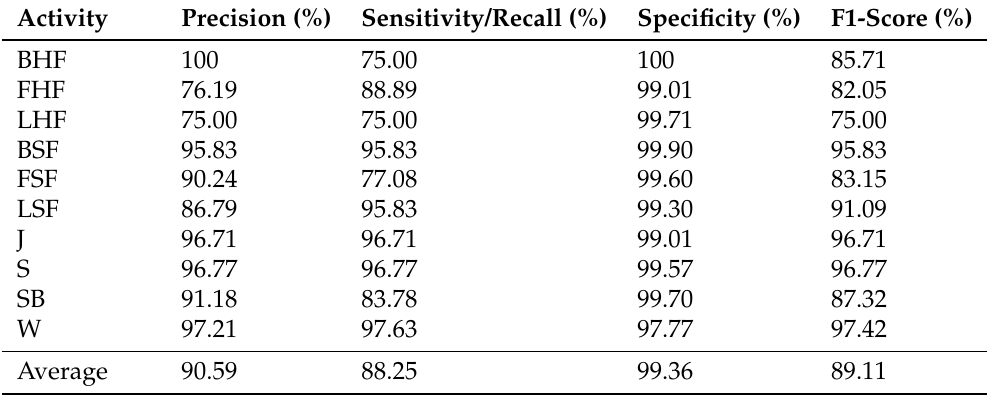
Table 2. ADL and Fall detection